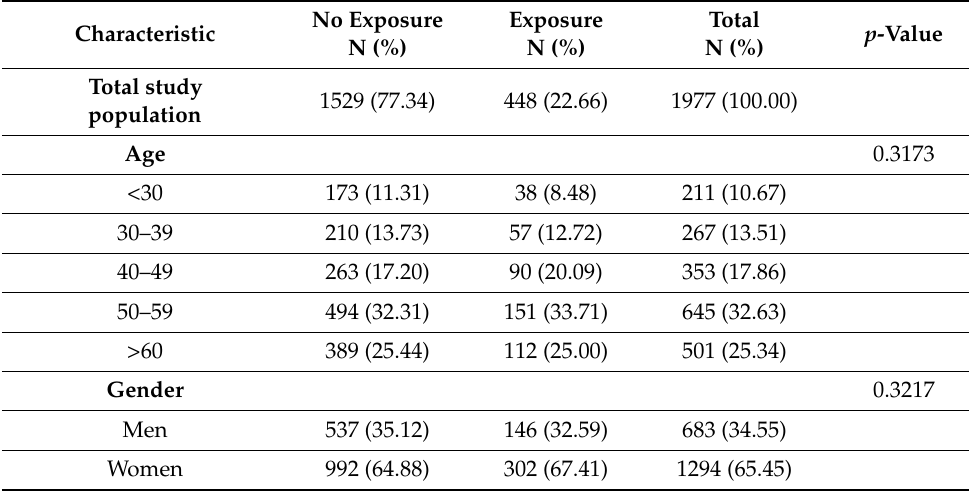
Table 1. Characteristics of the study population included in the analyses (n = 1977). The Northern Finnish Asthma Study